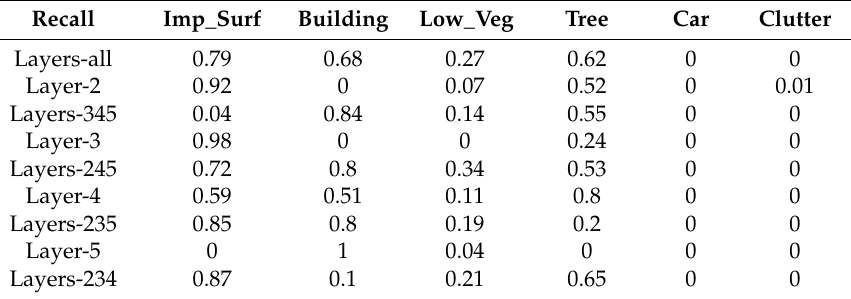
Table 2. The recall of different layers for different classes in elevation data.